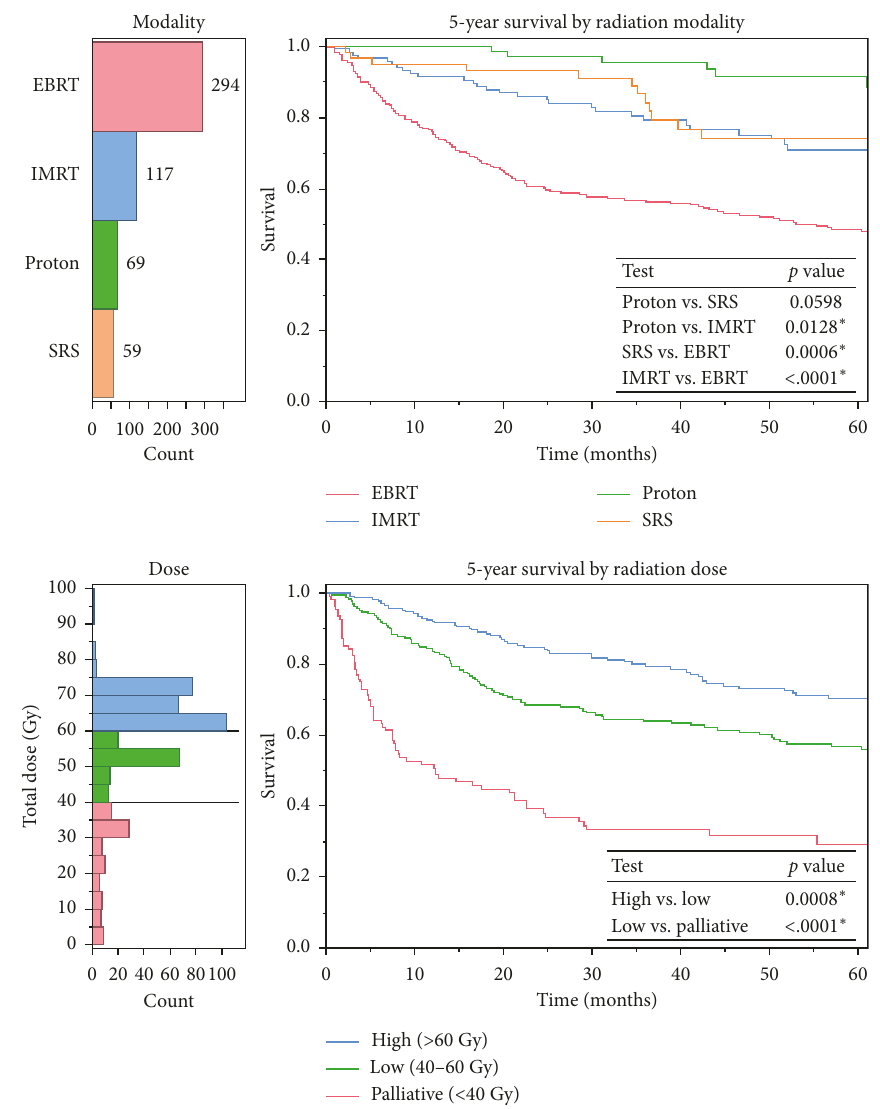
Figure 2: Kaplan–Meier curves comparing survival between radiation treatment groups, stratified by (a) modality and (b) dose. Modalities included EBRT, IMRT, PBT, and SRS. Dose groups included high-dose ( distributions shown to the left of survival curves. Log-rank tests comparing treatment groups included in KM curve inset, with alpha